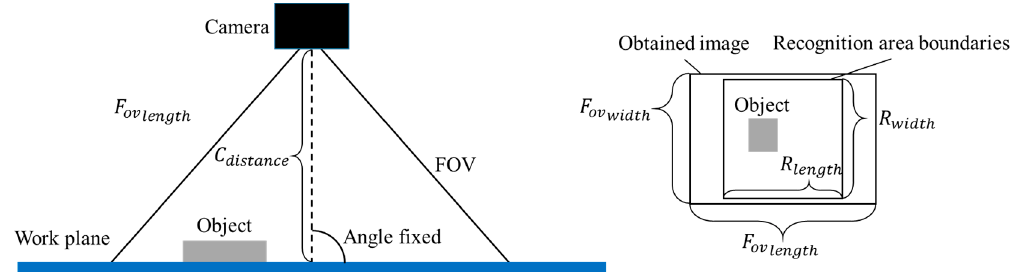
Figure 2. Illustration of the estimation of the FOV size. The positional relation between camera, object(s) and the work plane are shown on left side. The right side shows the length-width ratio of the recognition area and FOV. In the given example, the ratio of FOV is larger than that of the recognition area, which suggests FOV width to represent FOV size.